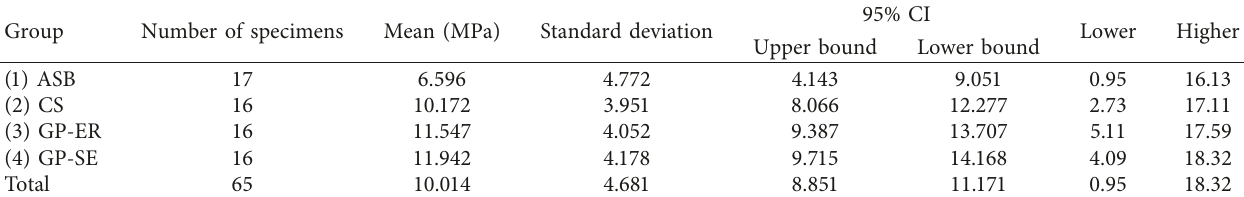
Table 2: Mean push-out bond strengths of different adhesive systems to intracanal dentin of primary lateral incisors in the four groups. Group Number of specimens